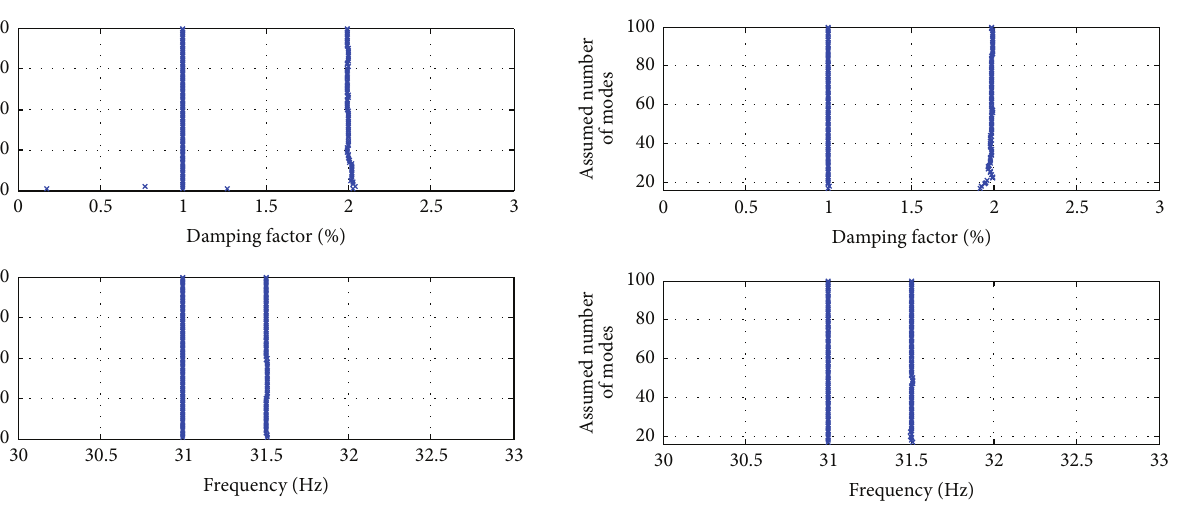
Figure 3: Stabilization diagram on eigenfrequencies and damping factorsforthetwo-DOFsystemusingshiftingpropertiesoftheblock controllability matrix.